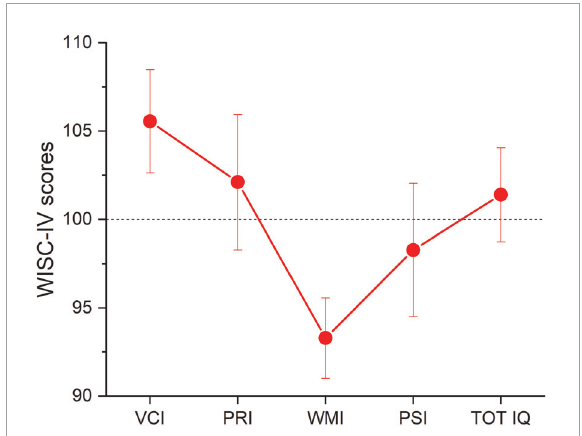
FIGURE1 WISC-IV: Wechsler Intelligence Scale for Children, 4th edition. CVI, Verbal Comprehension index; PRI, perceptual reasoning index; WMI, working memory index; PSI, processing speed index; TOT IQ, full scale quotient. Dashed line report normative data. Error bars report ± 1 s.e.m.